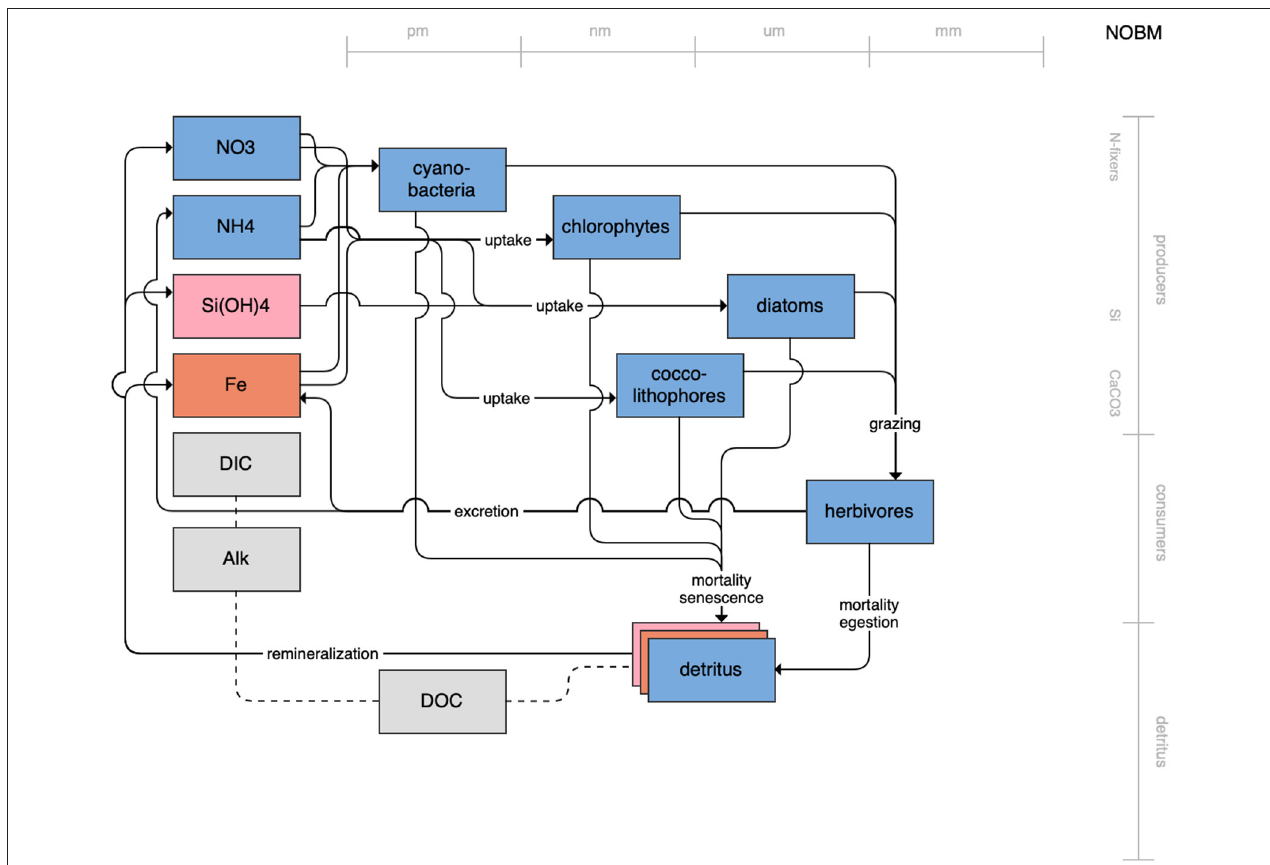
FIGURE 10 | Schematic for the NOBM model. See Figure 1 caption for